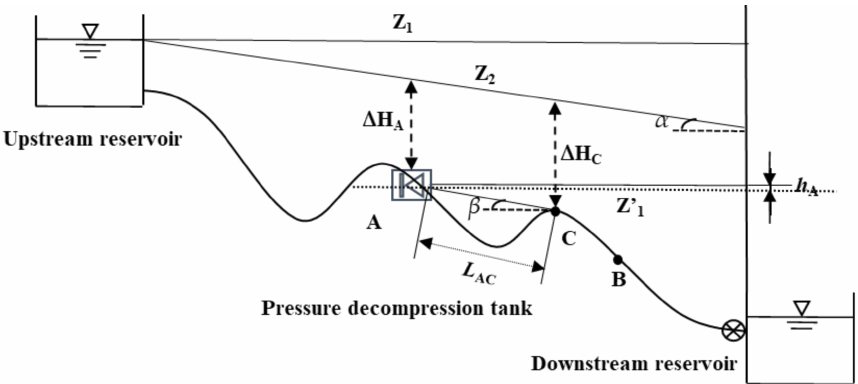
Figure 3. Schematic diagram of EDB location in long-distance and high-drop gravitational water supply system